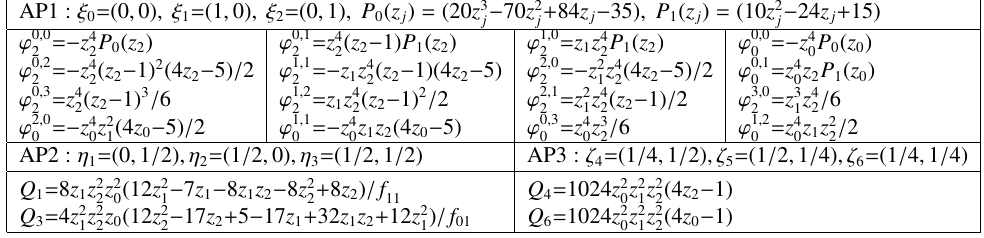
Table 2. The 20 HIPs p = 1, κ max = 4, κ (cid:31) = 1, p (cid:31) = 7, remaining 16 HIPs are obtained by permutation z 1